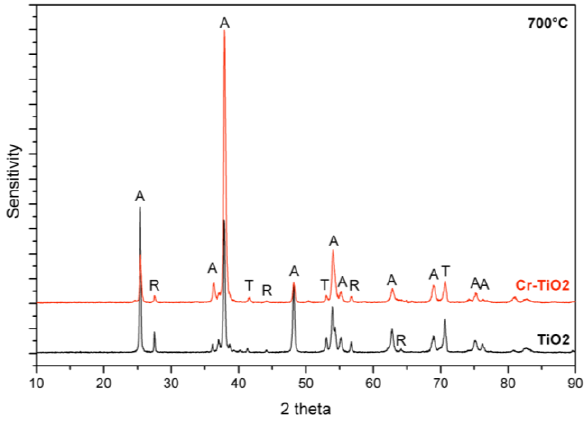
Figure 6. XRD diffractogrammes of TiO 700 °C. (A: Anatase, R: Rutile and T: Titanium).